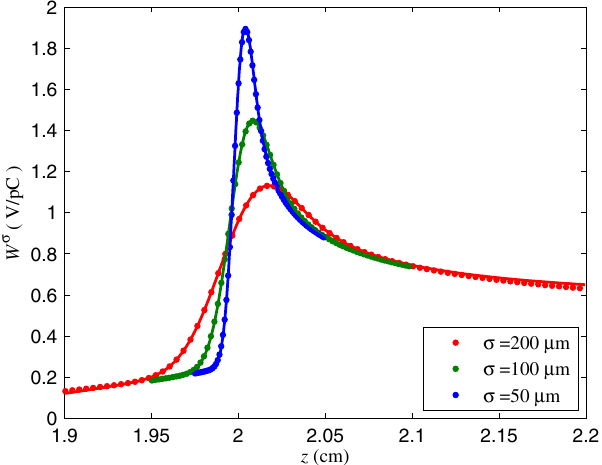
FIG. 8. Cavity wake potentials near z ¼ 2 g calculated directly with ECHO (dots) and reconstructed from W 200 (cid:8) m